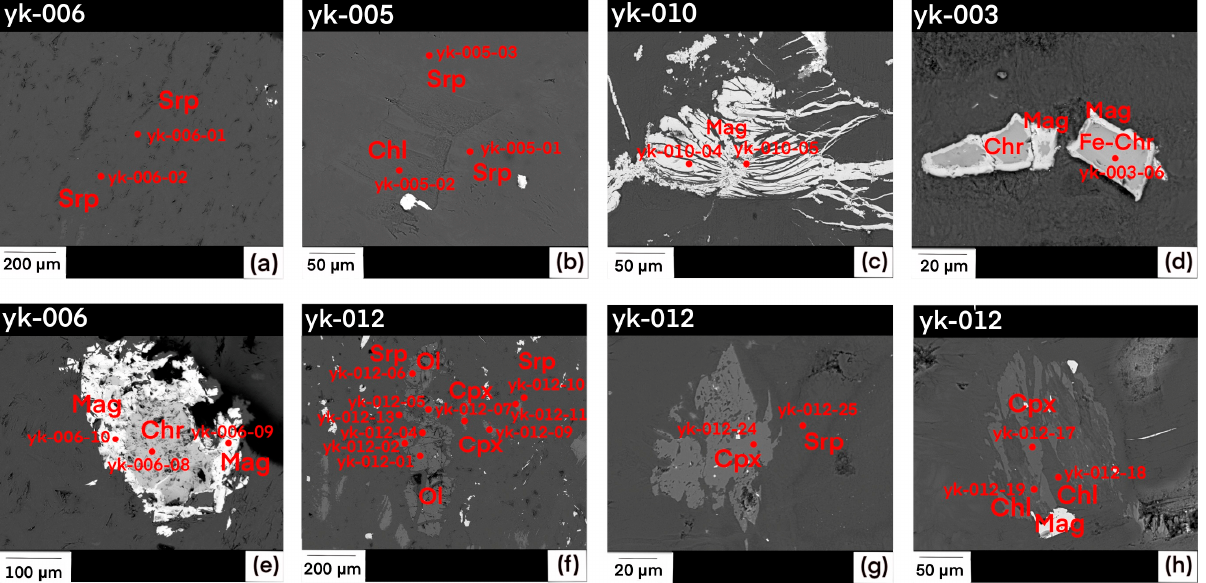
Figure 4. BSE images of “Laoshan Jade”: ( a ) serpentine; ( b ) chlorite; ( c ) heterogeneous disseminated magnetite; ( d ) idiomorphic–hypidiomorphic chromite with zonal texture; ( e ) chromite and irregular band; ( f ) altered olivine and pyroxene; ( g,h ) altered pyroxene.